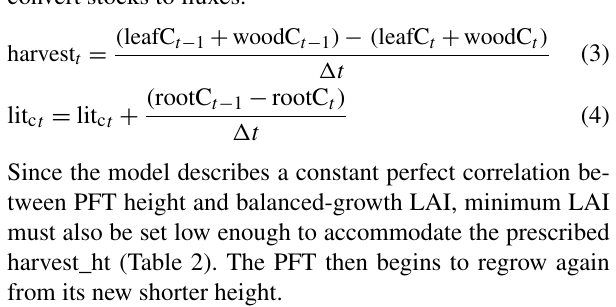
Table 1. Functionality and applications of JULES-BE. Function Simulated applications Continuous harvest Forest management (without felling) Biomass removal from agricultural land Periodic harvest Harvests of perennial crops (e.g. Miscanthus ) Short-rotation coppicing (e.g. poplar) Forestry rotations Assisted